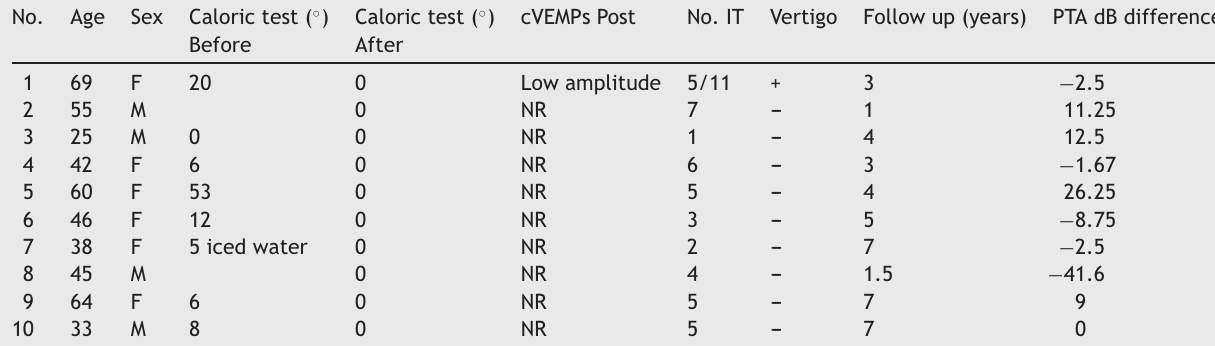
Table 1 Patients’ clinical characteristics, intervention, and follow